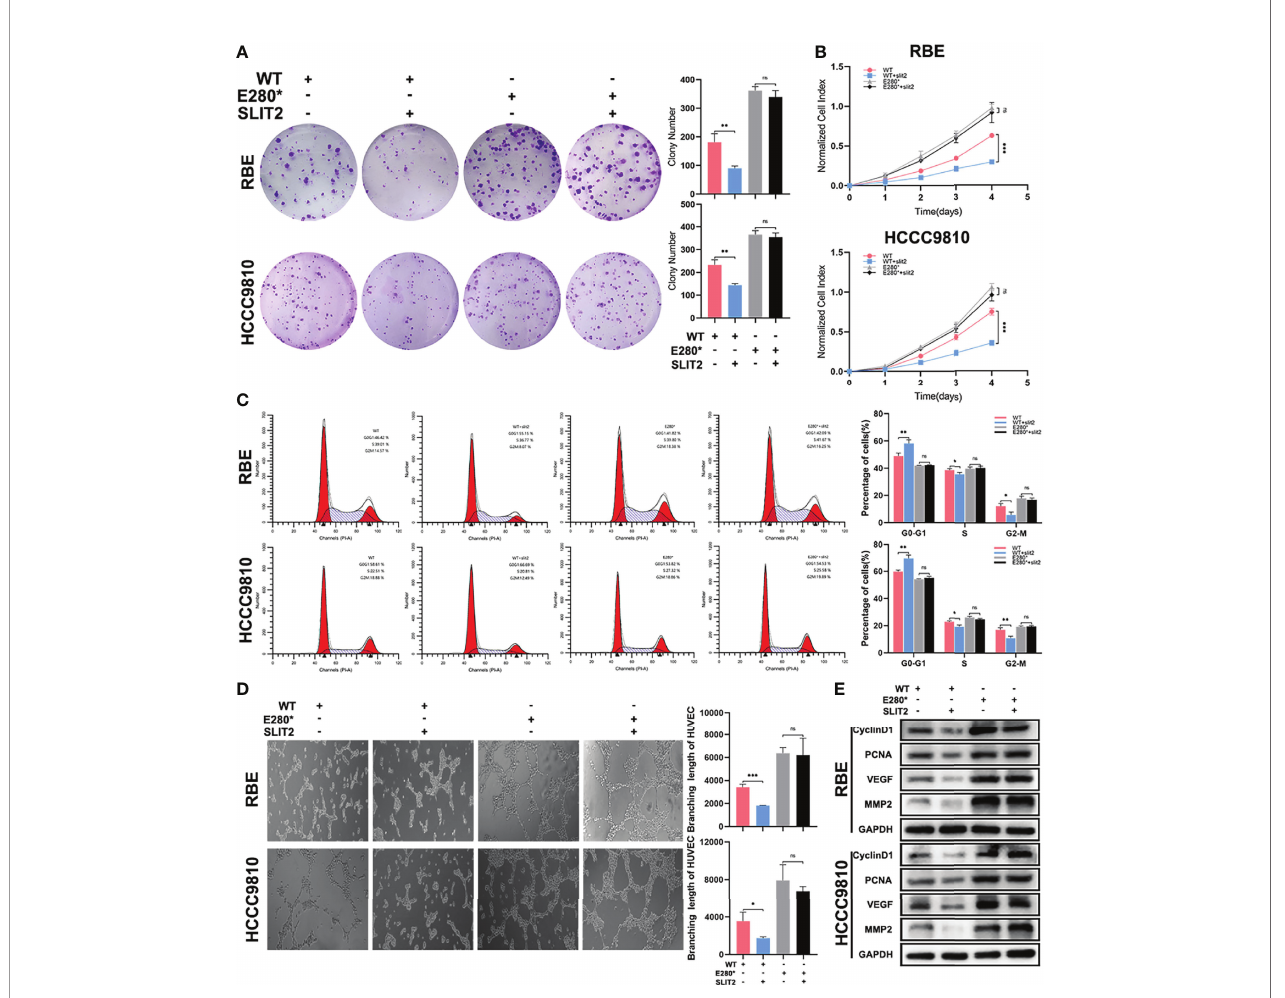
FIGURE 5 | ROBO1 E280 * disrupted the SLIT2-induced tumor-suppressing effects on proliferation and angiogenesis in cholangiocarcinoma. (A) SLIT2 treatment impaired the clone formation ability of ROBO1 WT cells but not that of ROBO1 E280 * cells. (B) SLIT2 treatment reduced the proliferation rate of ROBO1 WT cells but not that of ROBO1 E280 * cells. (C) Flow cytometry analysis of the cell cycle of wild-type and mutated RBE cells treated by SLIT2. (D) SLIT2 treatment did not decrease the branching length of human umbilical vein endothelial cell line in the ROBO1 E280 * group as in the ROBO1 WT group. (E) Western blotting analysis of the expression trend of cyclin D1, PCNA, VEGF, and MMP2 after SLIT treatment. * P < 0.05; ** P < 0.01; *** P < 0.001; ns, P >